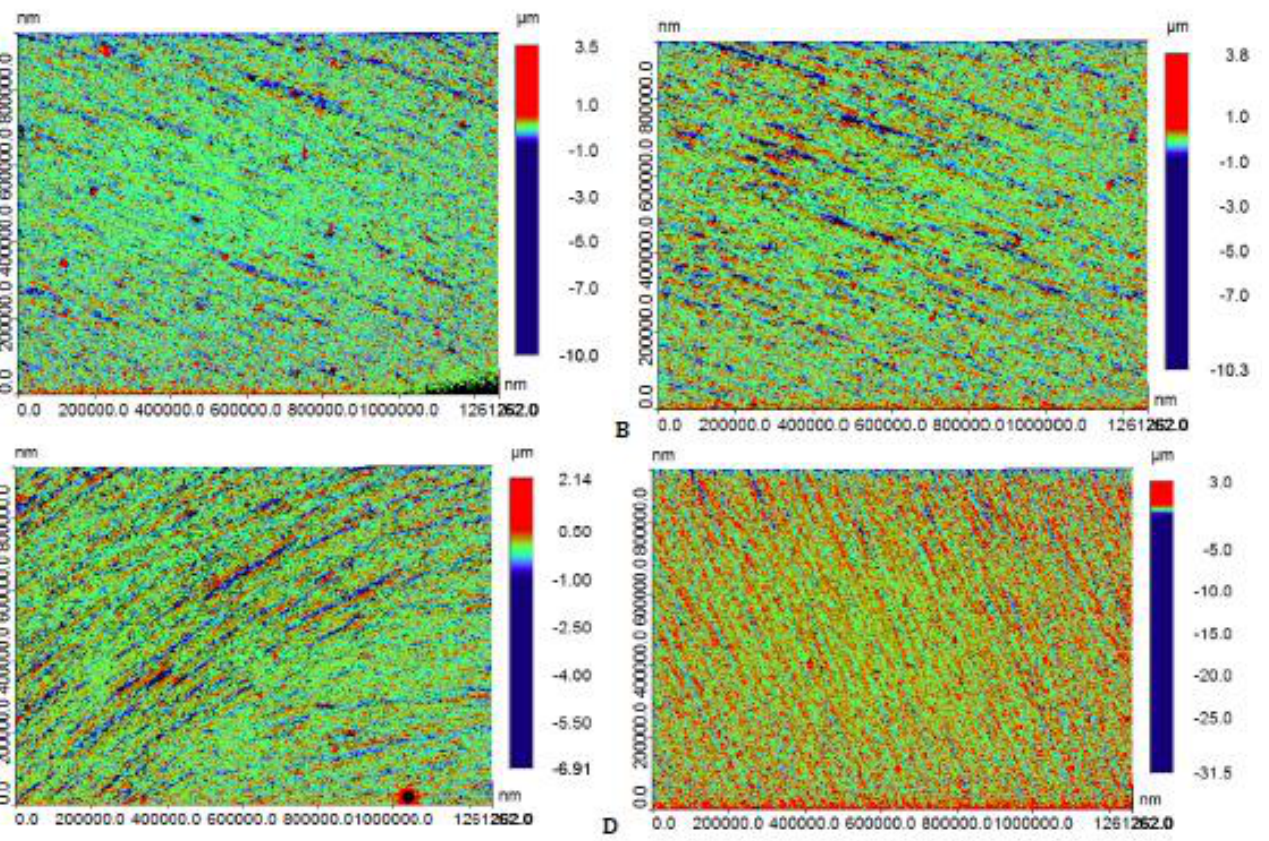
Figure 2. Surface roughness (Ra) micrographs for groups ( A ) Cast/LWT, ( B ) CAD-CAM, ( C ) DLP-Cast, and ( D ) SLM.